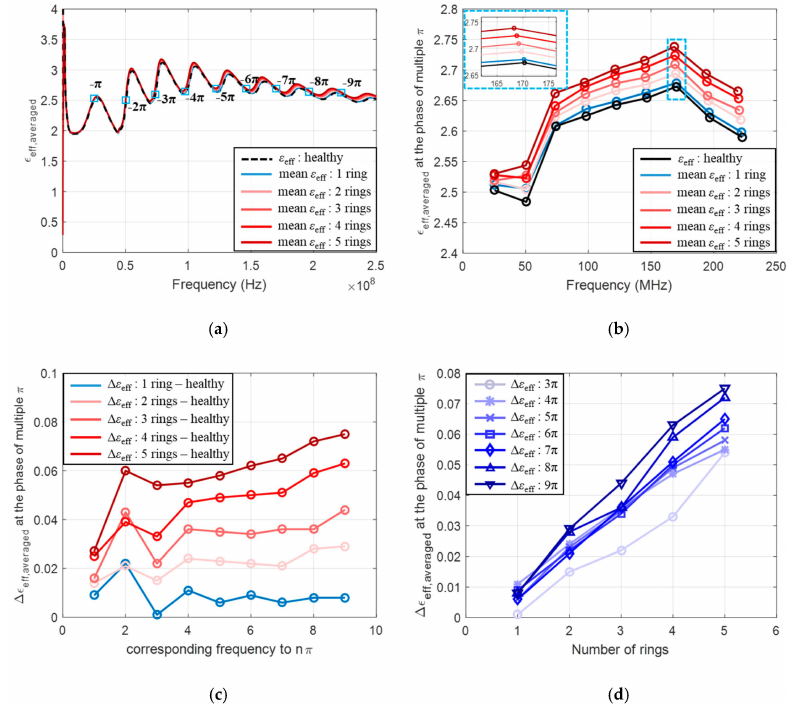
Figure 10. ( a ) Calculated average e ff ective permittivity for healthy and 1–5 rings installed using Equation (16); ( b ) Calculated average e ff ective permittivity at the multiples of π ; ( c ) Incremental (di ff erence) average e ff ective permittivity at the multiples of π ; ( d ) Incremental (di ff erence) average e ff ective permittivity as the number of rings